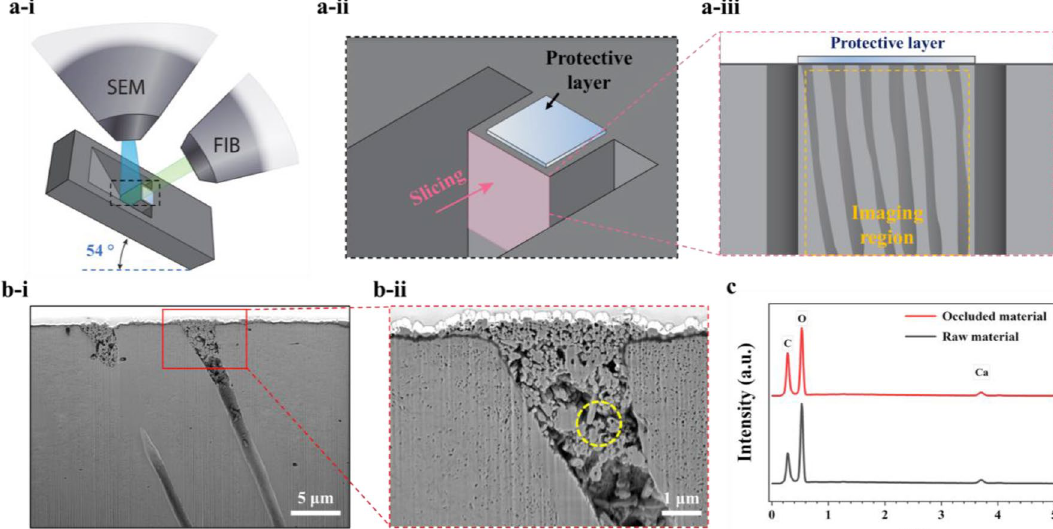
Figure 2. The EDS characterization of occluded tubules using FIB-SEM approach. ( a-i ) The schematic of the specimen setup in the FIB-SEM chamber for data acquisition. ( a-ii ) The illustration of a volume of dentin material prepared for serial FIB slicing. The pink arrow indicates the FIB slicing along the longitudinal section. A thin layer of Pt is deposited before FIB slicing. ( a-iii ) An example of a cross-section presenting the exposed tubules during FIB slicing. ( b ) The cross-sectional view of the dentinal tubule occluded by the testing toothpaste under low magnification ( b-i ) and high magnification ( b-ii ). The yellow dashed circle indicates the location of probing the occluded material within the dentinal tubule via EDS analysis ( c ).